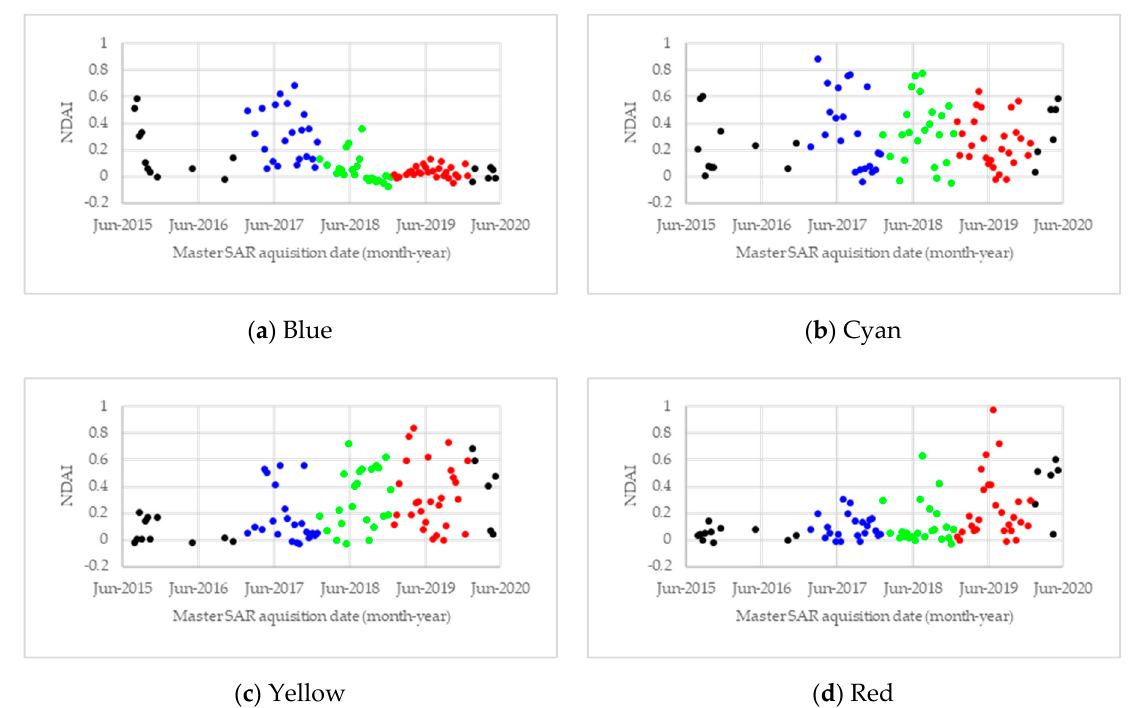
Figure 24. The 12-day NDAI time-series graphs of the excavation site in ( a ) blue (B), ( b ) cyan (C), ( c ) yellow (Y), and ( d ) red (R) points of Figure 23c. The red, green, and blue dots in the graphs indicate the data used for generating the RGB composite of the annually averaged NDAI images, while black dots were not.